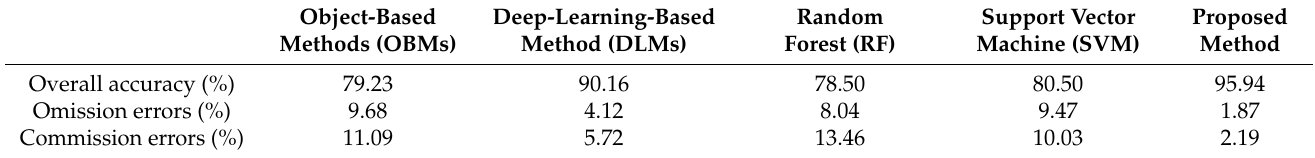
Figure 10. The results of change detection of four methods based on two-temporal images. ( a ) The object-based methods (OBMs), ( b ) the deep-learning-based method (DLMs), ( c ) the random forest (RF), and ( d ) the support vector machine (SVM). Note: the white areas denote unchanged areas in Figure 10. Table 9. Accuracy of change detection results for four